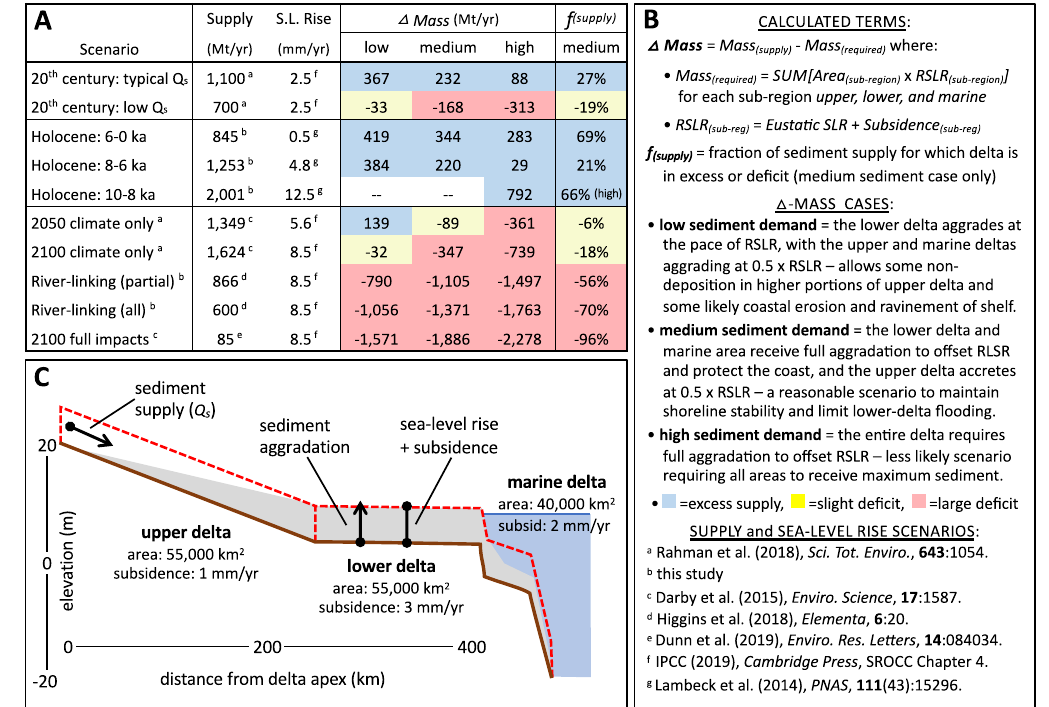
B Anexplanation of the calculated terms, the conditions for each Δ Mass case, and the data sources are provided along with C , a schematic diagram of the mass- balance model for the delta. The Holocene: 10 – 8 ka scenario considers only the high sediment demand case, as the wholedelta aggraded in response to rapid sea- level rise during this